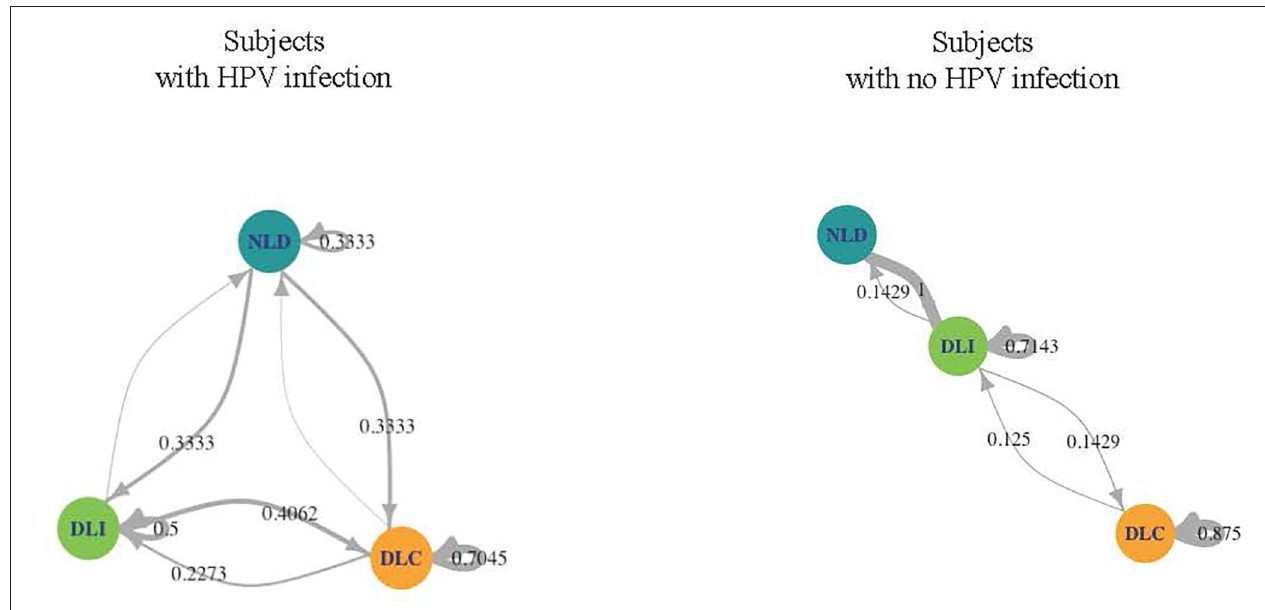
FIGURE 3 | Dynamics of the CW microbiome based on Markov chain modeling. Arrow weights are proportional to the maximum-likelihood-estimate of the transition probabilities between microbiota dominated by L. crispatus (DLC), L. iners (DLI), or non- Lactobacillus (NLD). Women who acquired HPV 16 had higher transition probabilities between microbiota states than women with no history of HPV infection.